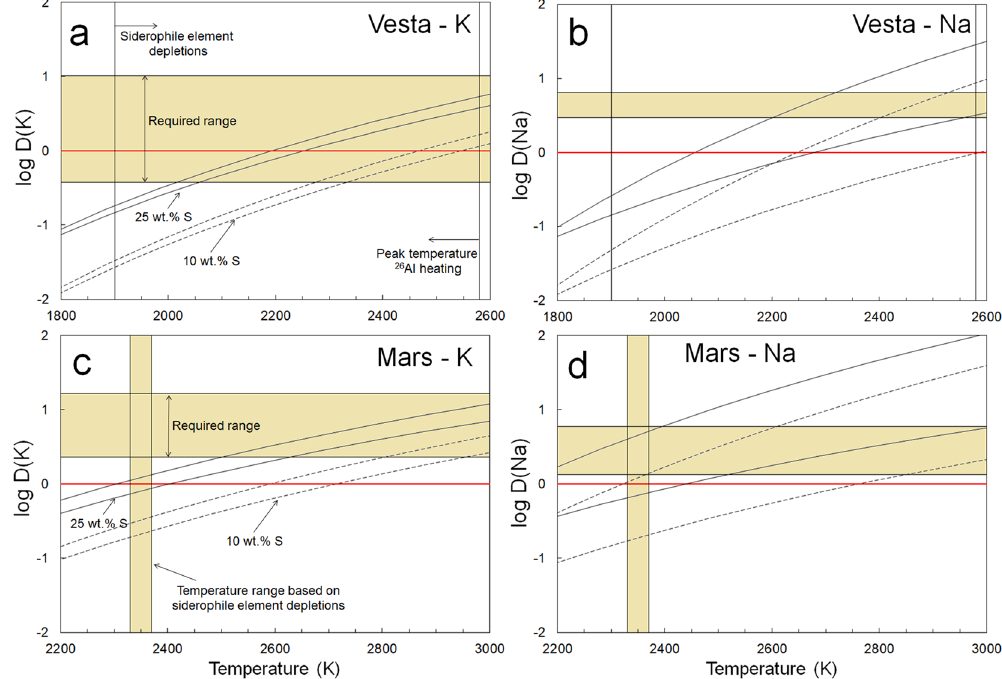
Figure 3. ( a , b ) Calculated K and Na partition coefficient ranges for asteroid Vesta, assuming the formation of a 20 to 30 mass % core at − 2.2 ± 0.2 log units below the iron-wüstite buffer 30,52,83 , ( c , d ) Comparable calculations for Mars, assuming the formation of a 20 to 25 mass% core at − 1.25 ± 0.25 log units below the iron-wüstite buffer 34,41–43 , for different core sulfur abundances. Ranges include propagated errors on temperature terms. Plotted for reference are the inferred peak temperature due to radiogenic decay of 26 Al for Vesta 49 and core formation temperatures inferred from siderophile element depletions for both bodies 30,41,42,52 . Data sources used to calculate observed alkali element depletions in Mars and Vesta are listed in the Supplementary Materials file. Red line in bold marks the transition from lithophile to siderophile behavior (log D =